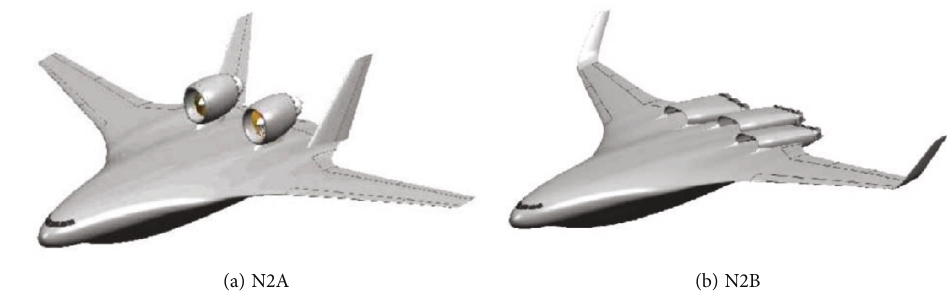
Figure 2: N2A and N2B con fi gurations [18].